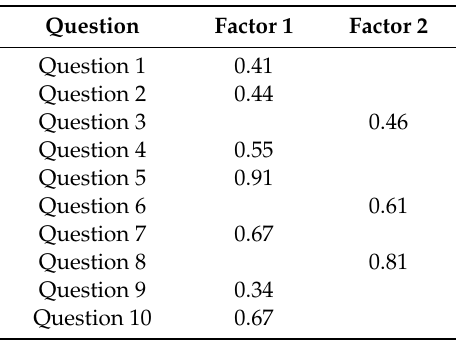
Table 6. Rotated factor matrix.